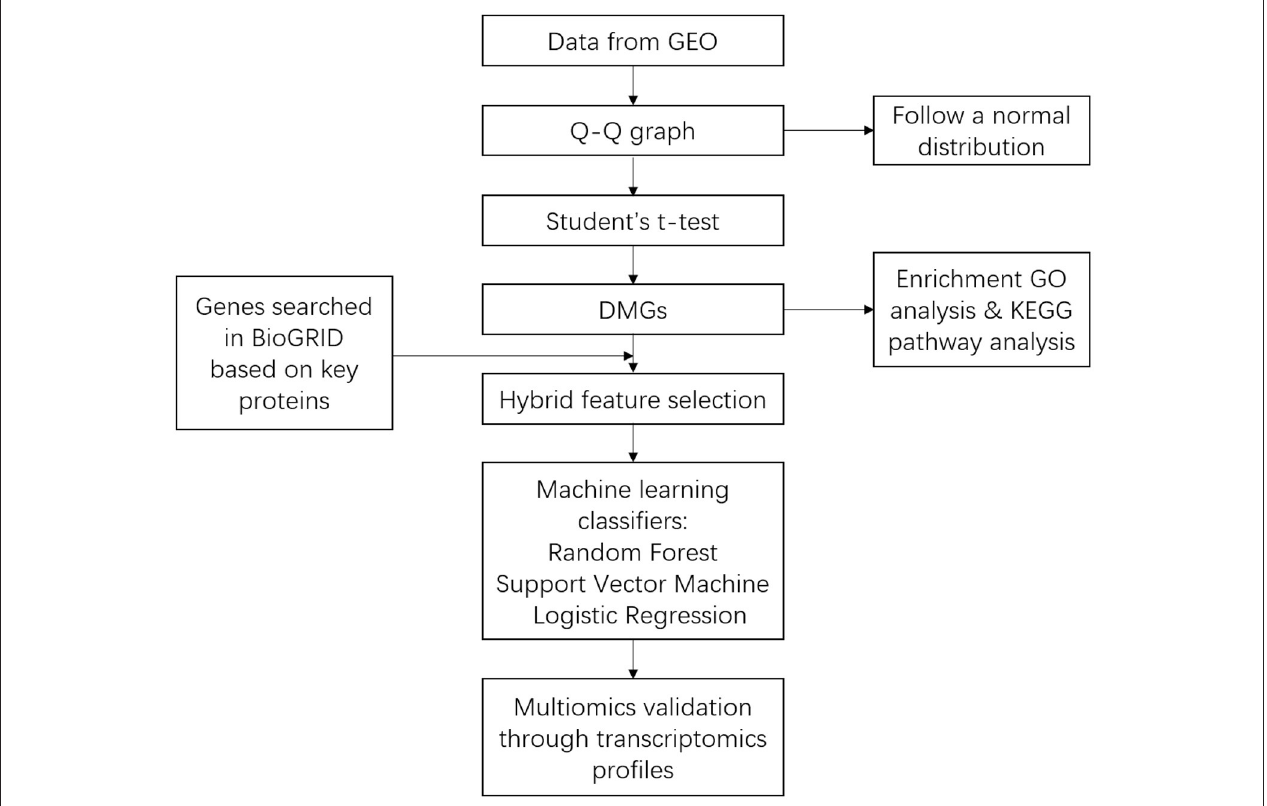
FIGURE 1 | Pipeline showing the approach used for bioinformatic analysis and building the machine learning